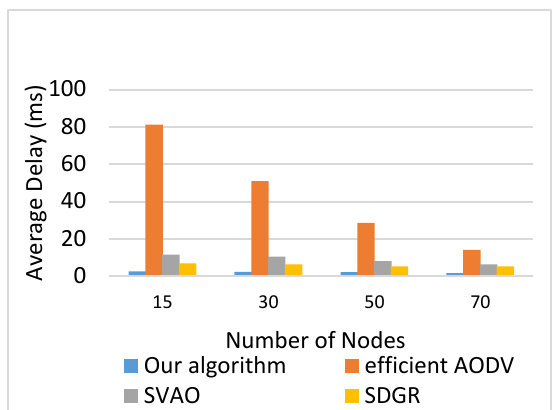
Figure 7. Average end-to-end delay.